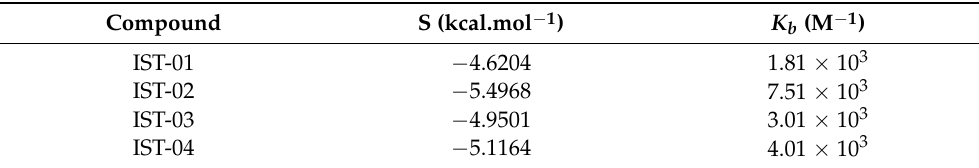
Table 2. Binding parameters including scoring function (S) and binding constant ( K b ) of isatin derivatives from molecular